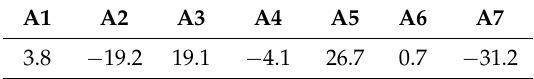
Table 1. Overall mean percentage reduction of the agitation for each pre-solution proposed.